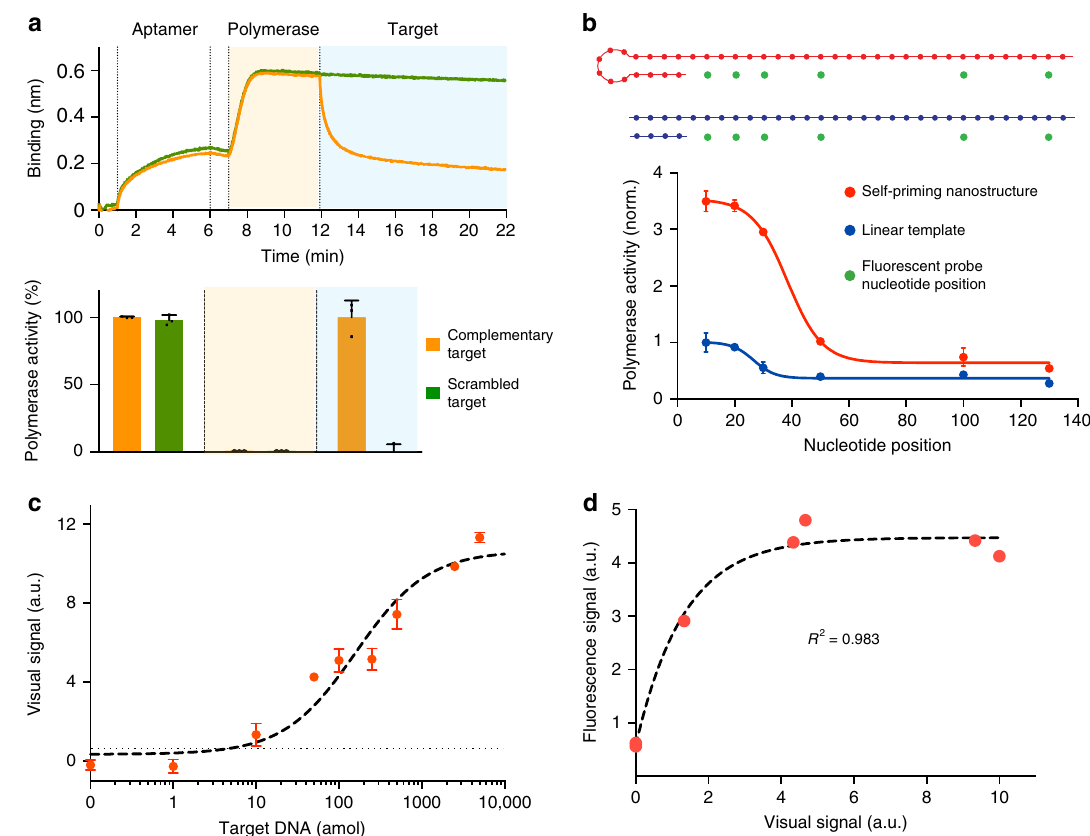
Fig. 2 Nucleic acid quanti fi cation with enVision. a Recognition nanostructure assembly and activity. The recognition nanostructure was assembled and incubated with complementary or scrambled target DNA sequences, to determine the resultant polymerase association and activity. (Top) Real-time sensorgram of molecular binding. We performed a series of operations, namely aptamer immobilization, addition of polymerase, and incubation with target DNA sequences. Molecular binding was monitored in situ through bio-layer interferometry to determine polymerase association. (Bottom) The corresponding polymerase activity was determined at the end of each operation via a parallel experiment using a Taqman assay ( fl uorescence measurement of 5 ′ exonuclease degradation of Taqman probes). Note the complete recovery of polymerase activity upon incubating with complementary target DNA. b Signaling nanostructure activity. In a comparative experiment, the self-priming signaling nanostructure and its similarly-sized linear template were treated with equal concentration of active DNA polymerase. The polymerase activity was determined at different nucleotide positions away from the starting primed sites, through 5 ′ exonuclease degradation of differentially placed Taqman probes (positions indicated as green dots). c Detection sensitivity of the enVision system. The detection limit (dotted line) was determined by titrating a known amount of target DNA and measuring their associated visual signals. All visual signals were acquired through a smartphone. d Correlation between the enVision and fl uorescence measurements on varying quantities of target DNA. The visual signal matched well with the fl uorescence signal ( R 2 = 0.9828) and demonstrated a wider dynamic range. All measurements were performed in triplicate, and the data are displayed as mean ± s.d. a.u. arbitrary